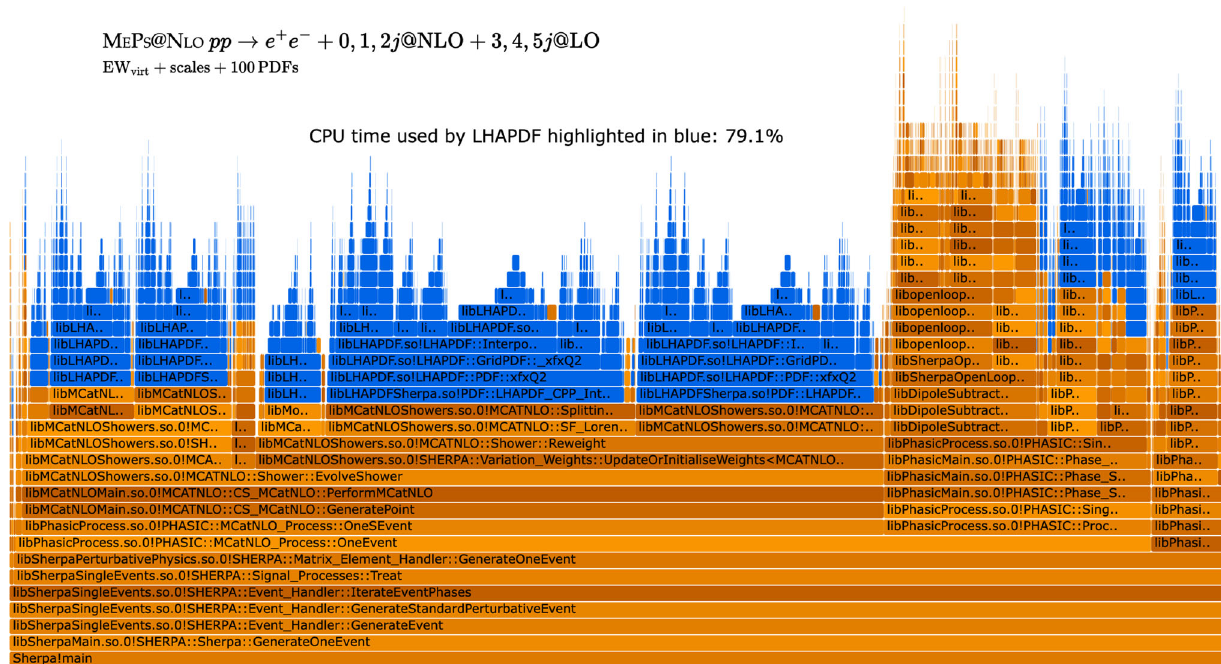
Fig. 2 CPU profile of 1000 MC partially unweighted pp → e + e − +jet events generated by S HERPA 2.2.11 interfaced with L HAPDF 6.2.3. The 79% of run-time spent within L HAPDF in the call-stack is highlighted in blue